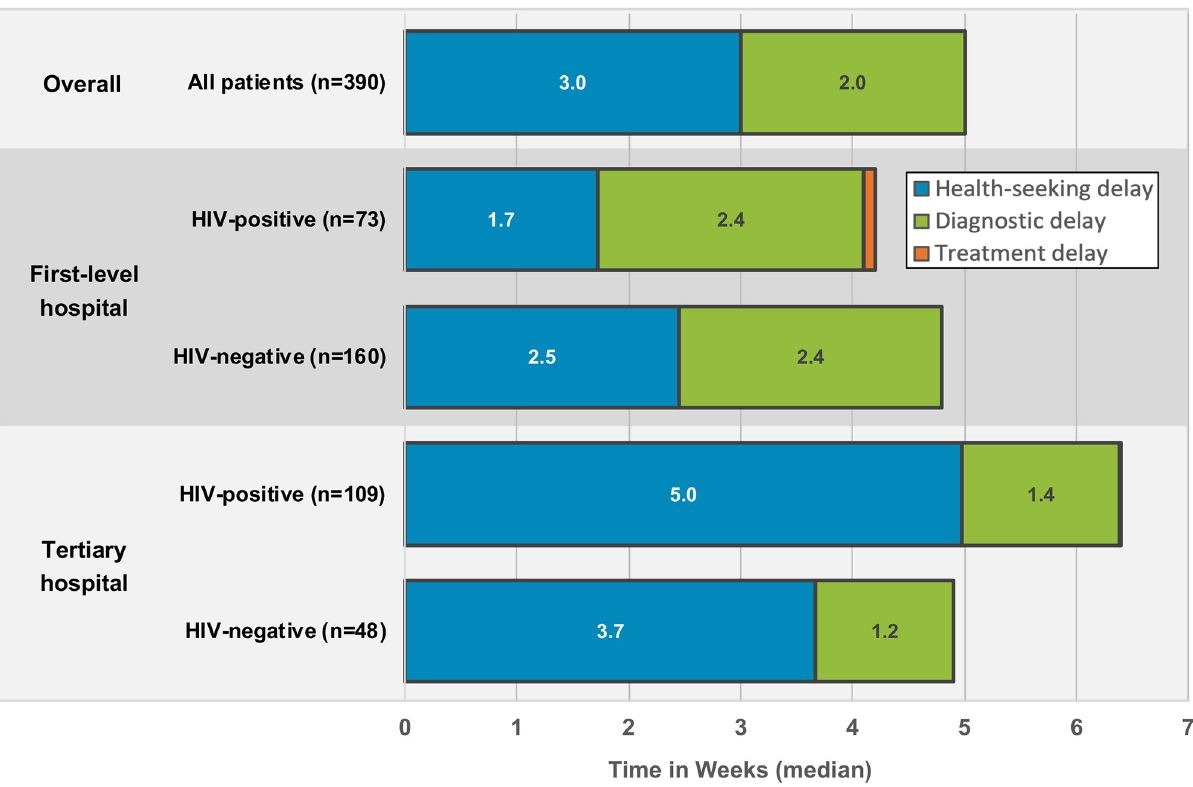
Fig 2. Tuberculosis patient care pathways in Zambia, according to HIV status by enrolment site.